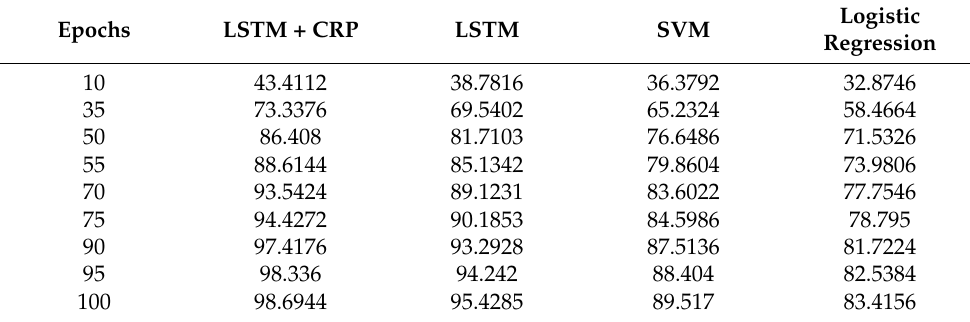
Table 6. Multiple epochs of testing data R 2 vs. various